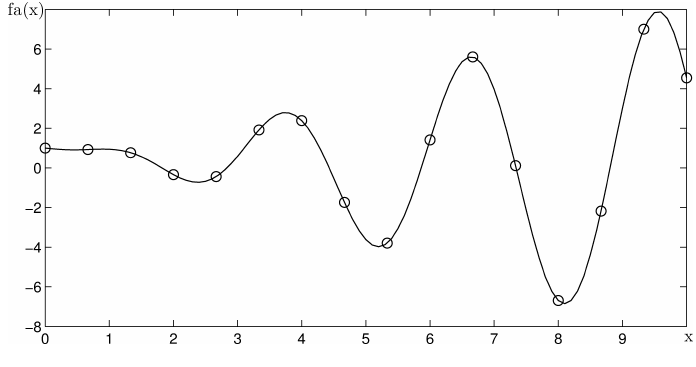
Fig. 4. Algebraic interpolant of f a .x/ on interval Œ0;10(cid:141) (the interpolant coincides with the function; circles denote nodes of the equispaced grid).